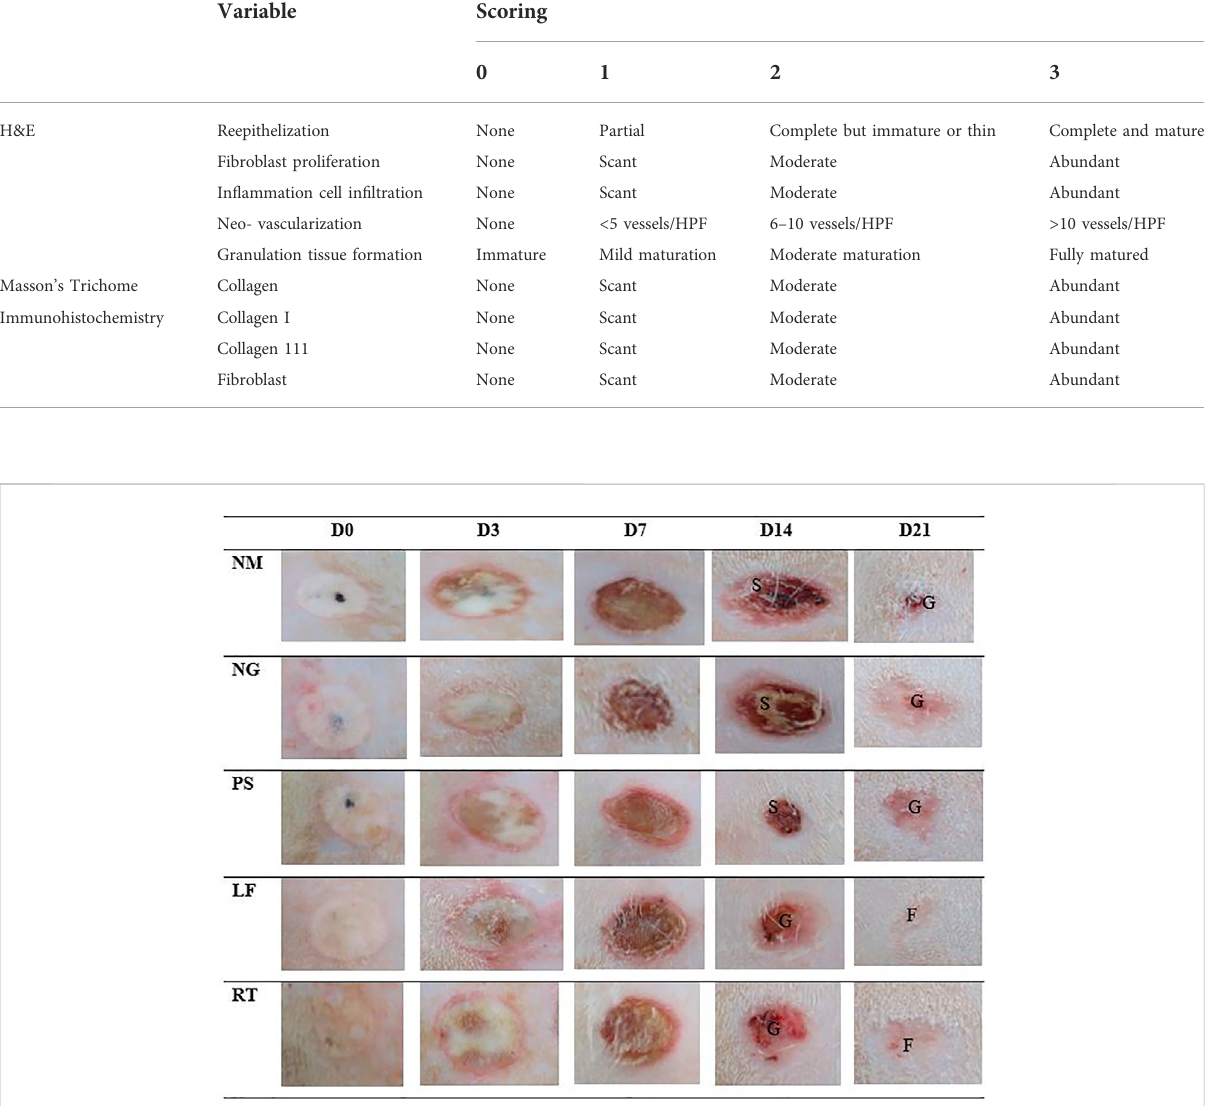
TABLE 2 Scoring system for Hematoxylin & Eosin, Masson ’ s Trichome and immunohistochemistry staining. Source: (Abramov et al., 2007).